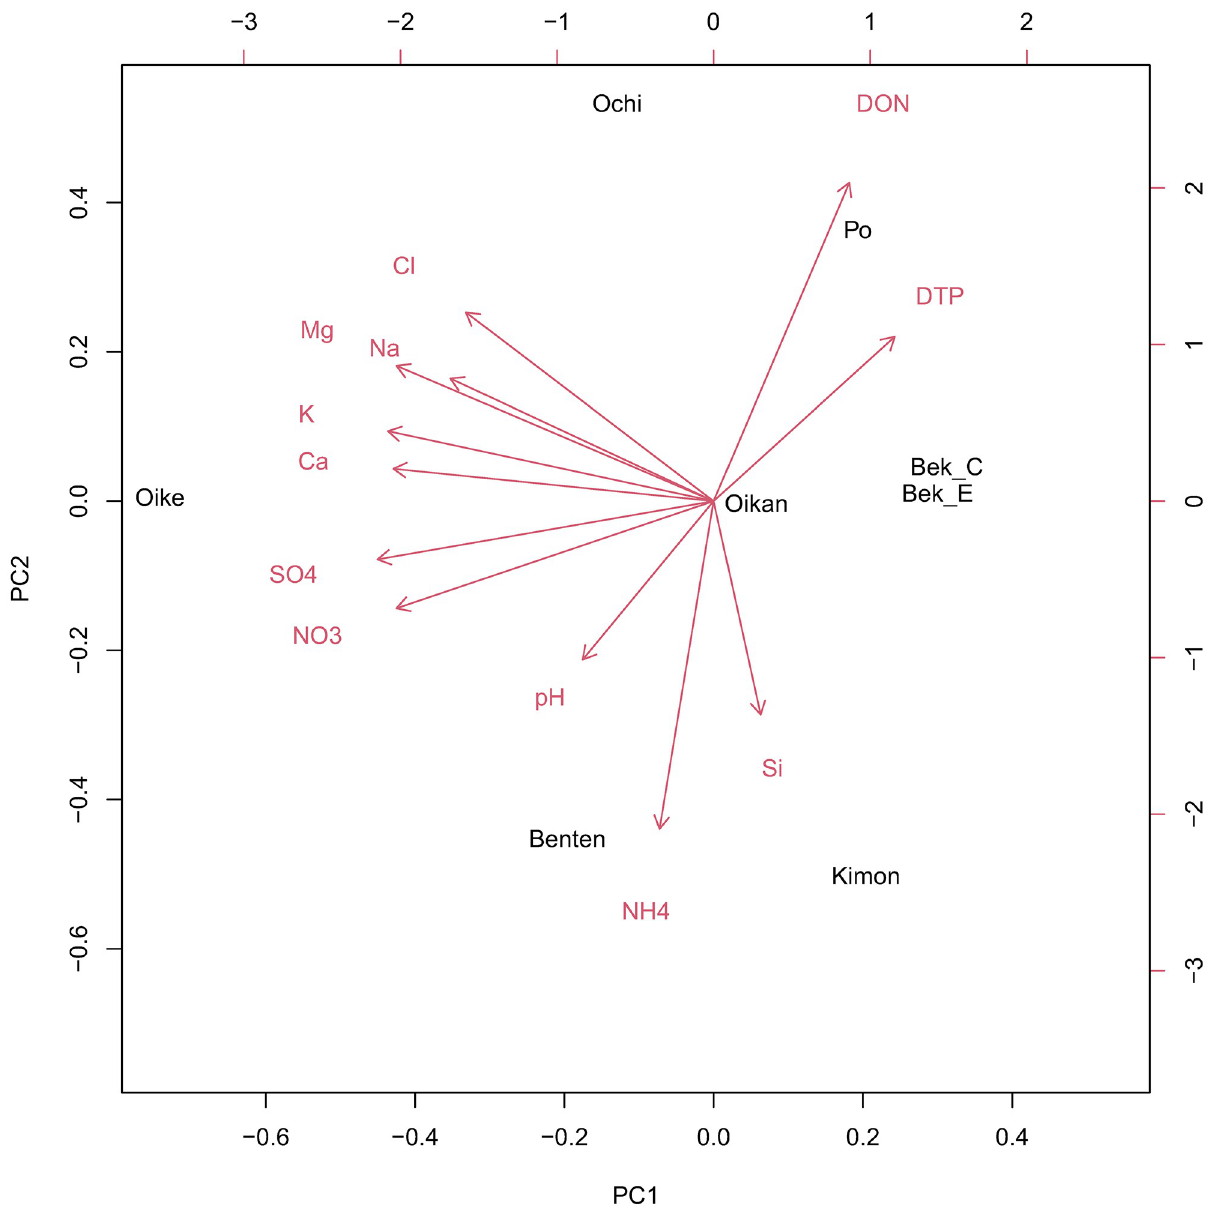
Fig 2. Principal component analysis (PCA) plot of eight Myrica gale var. tomentosa populations. Red arrows indicate the parameters used as variables of soil water chemistry. Black characters indicate the abbreviation of populations in Table 1; Oike: Oike, Po: Po, Ochi: Ochiishi, Bek_C: Bekanbeushi_Center, Bek_E: Bekanabeushi_Edge, Oikan: Oikanamai, Kimon: Kimonto, Benten: Bentennnuma.